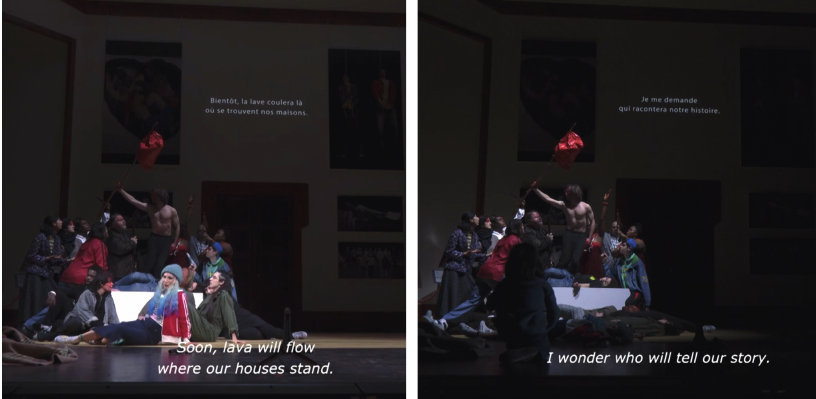
Figg. 6 and 7 Final scene. Still frame from the streamed performance on GTG Digital (February 19,